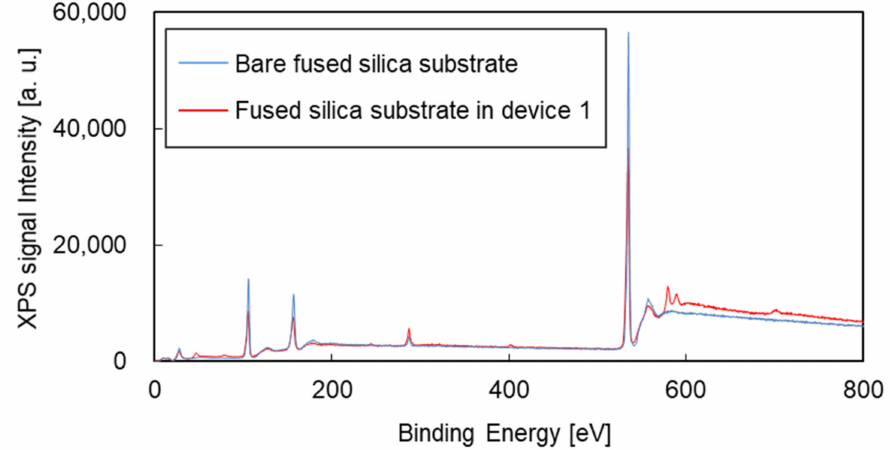
Figure 7. XPS signals for fused silica substrates before and after channel